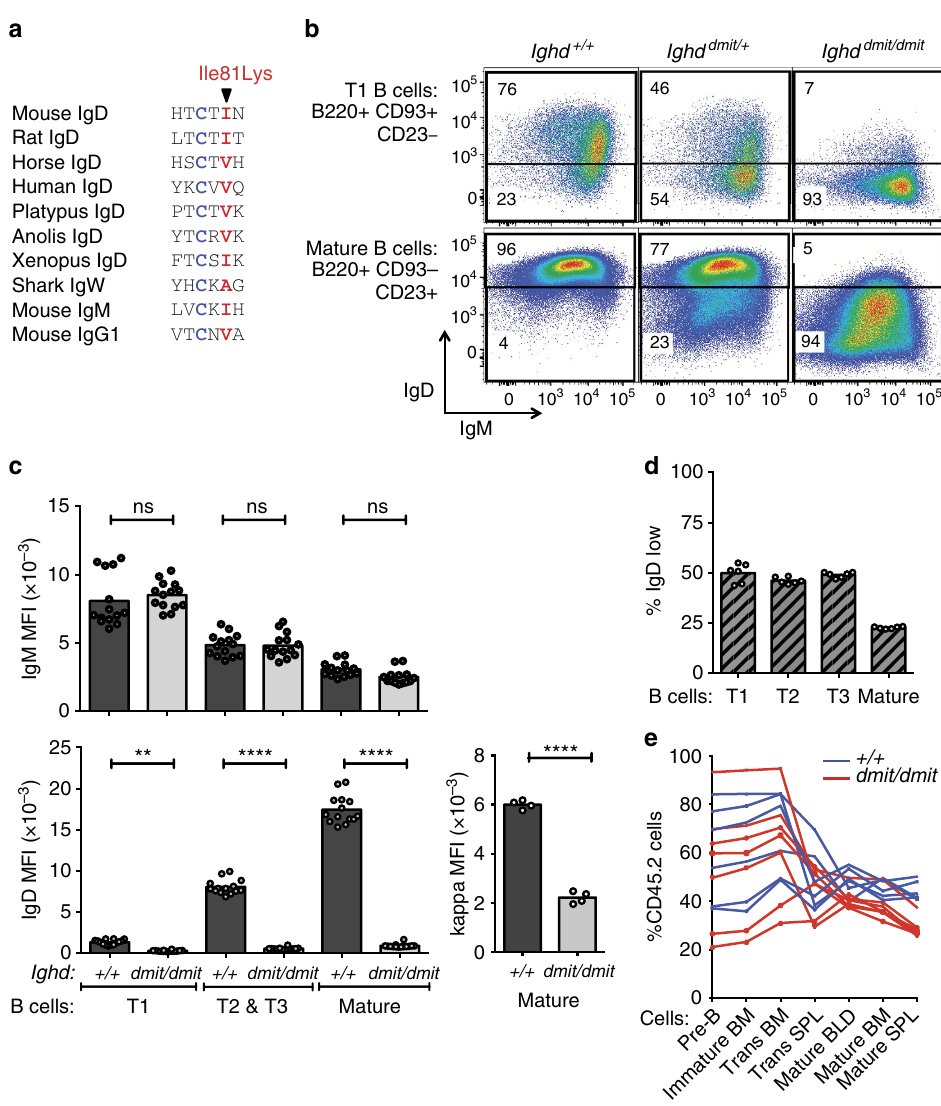
Figure 3 | Surface IgD promotes mature B cell accumulation independently of effect on IgM. ( a ) Alignment of b -sheet F in C H 1 domains of the indicated proteins, showing the hydrophobic core Ile residue mutated to Lys in IgD of the dimit strain (red), flanking the Cys forming the intradomain disulphide bond (blue). ( b ) Representative IgD and IgM expression on splenic B cells from mice of the indicated Ighd genotypes, gated as shown in Supplementary Fig. 9 on the CD93 þ CD23 (cid:2) T1 subset (top) or the CD93 (cid:2) CD23 þ mature follicular subset (bottom). Shown are gates used to resolve cells expressing the mutant or wild-type Ighd alleles in heterozygotes. Note that wild-type IgD is expressed at 10-fold lower MFI on T1 cells, necessitating a lower gate for T1 cells expressing wild-type IgD. ( c ) Surface IgM, IgD and kappa light chain MFI on the indicated B cell subsets from individual mice of the indicated